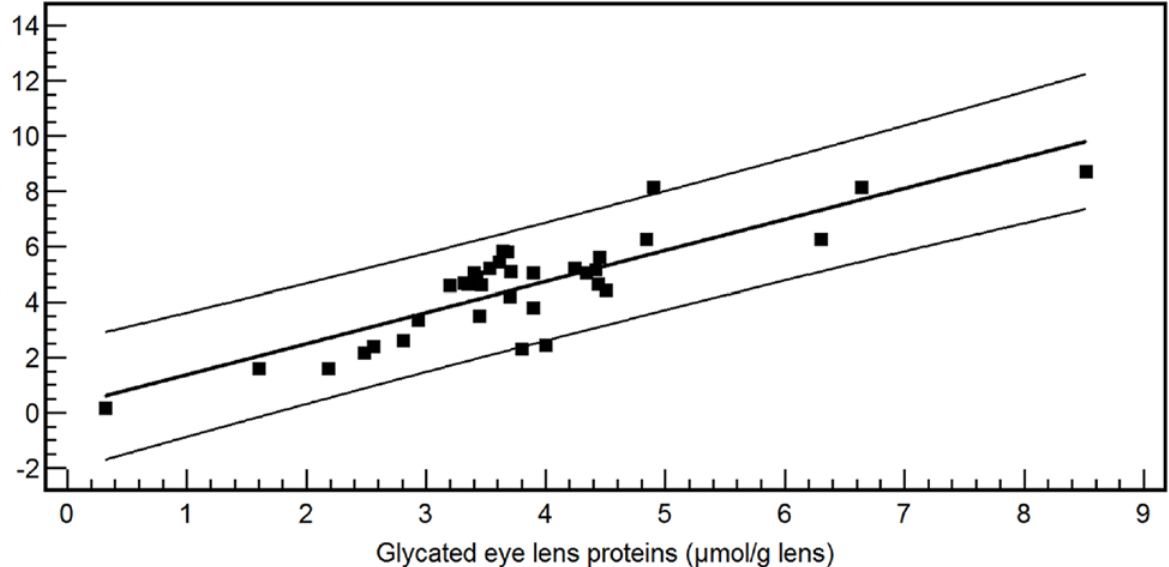
Fig 4. Correlation between glycated nail proteins and glycated eye lens proteins in the group of diabetes patients (n = 35). The equation of linear regression is y (glycated nail proteins) = 0.26 + 1.12 x (glycated eye lens proteins) (r2 = 0.71; P < 0.001).